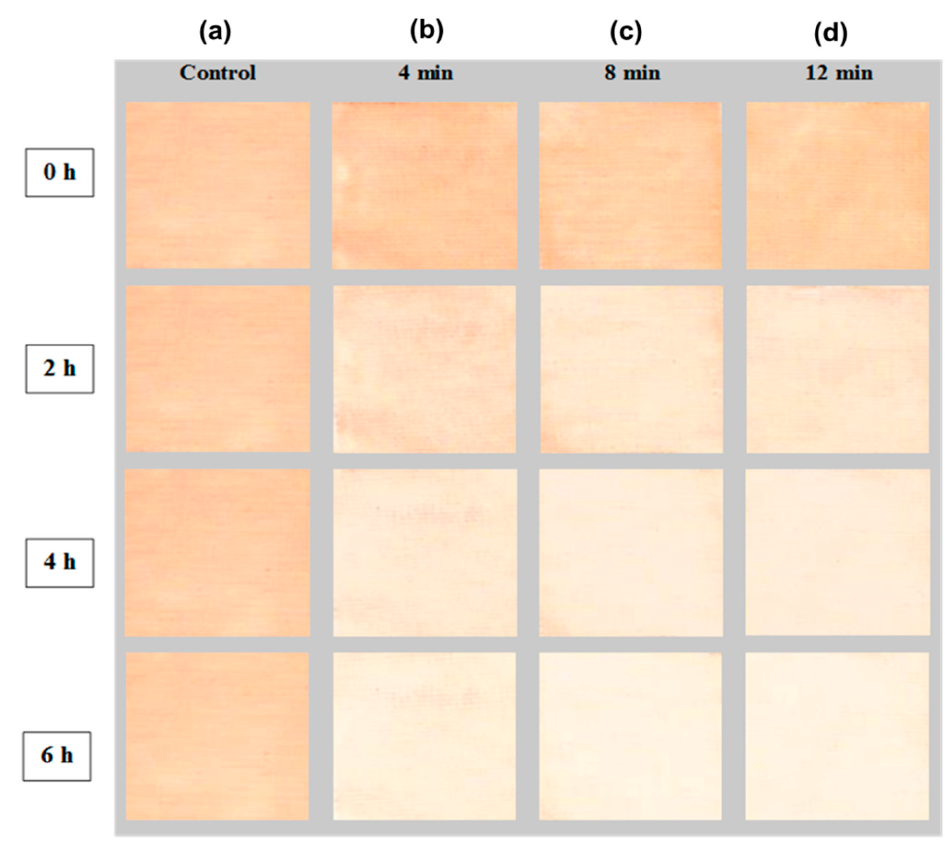
Figure 6. Photocatalytic degradation of the Orange II dye for, ( a ) control, ( b ) 4 min, ( c ) 8 min, and ( d ) 12 min.